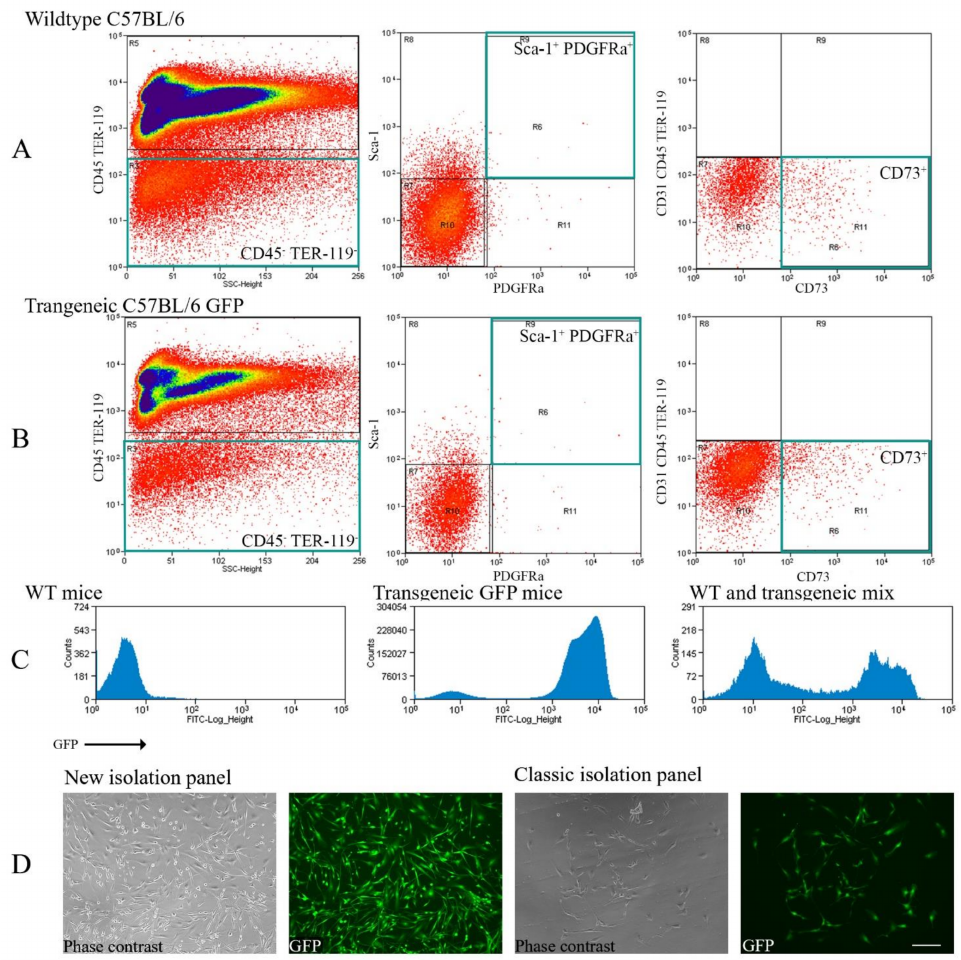
Figure 1. Comparison between the classic FACS staining panel and the new protocol to isolate freshly purified MSCs. ( A ) Displays whole bone marrow cells from wild-type C57BL/6 mice. ( B ) Shows whole bone marrow cells from transgenic GFP C57BL/6 mice. Green squares indicate the isolated populations. The staining panel were either CD45 TER-119 Sca-1 + PDGFR- α + ( middle ) or CD31 − CD45 TER-119 CD73 + ( right ). ( C ) Exhibits the GFP signal in the wild-type ( left ), GFP transgenic ( middle ), and wild-type-transgenic mix ( right , only for illustration). ( D ) Depicts isolated cells after 2 to 4 days of culture. The culture was only for illustrative purpose, not for transplantation. Scale bar = 100 µ m, 200 ×